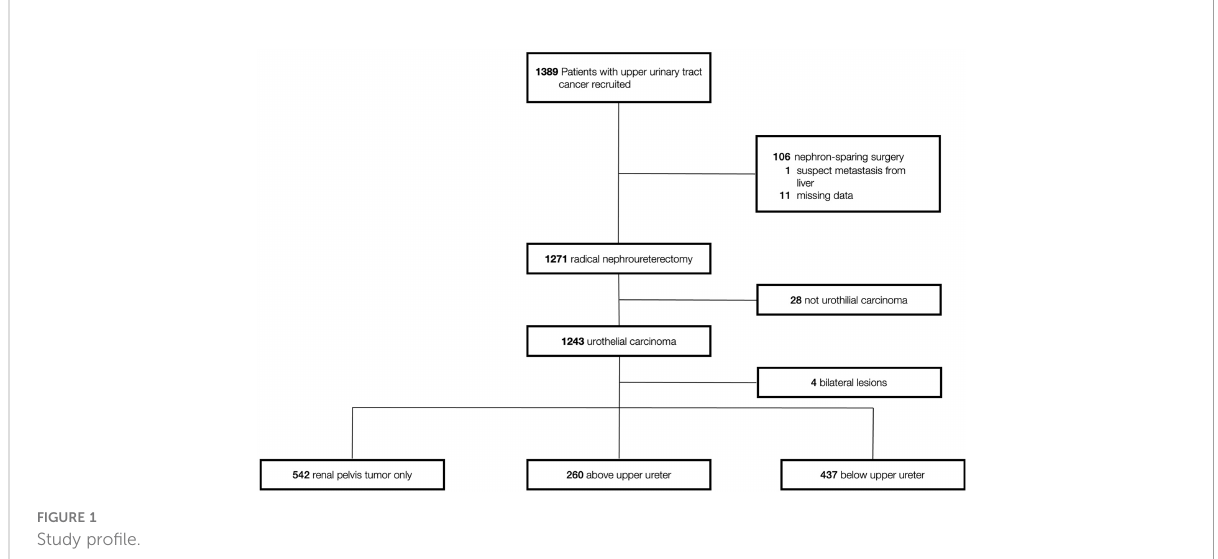
FIGURE 1 Study pro fi